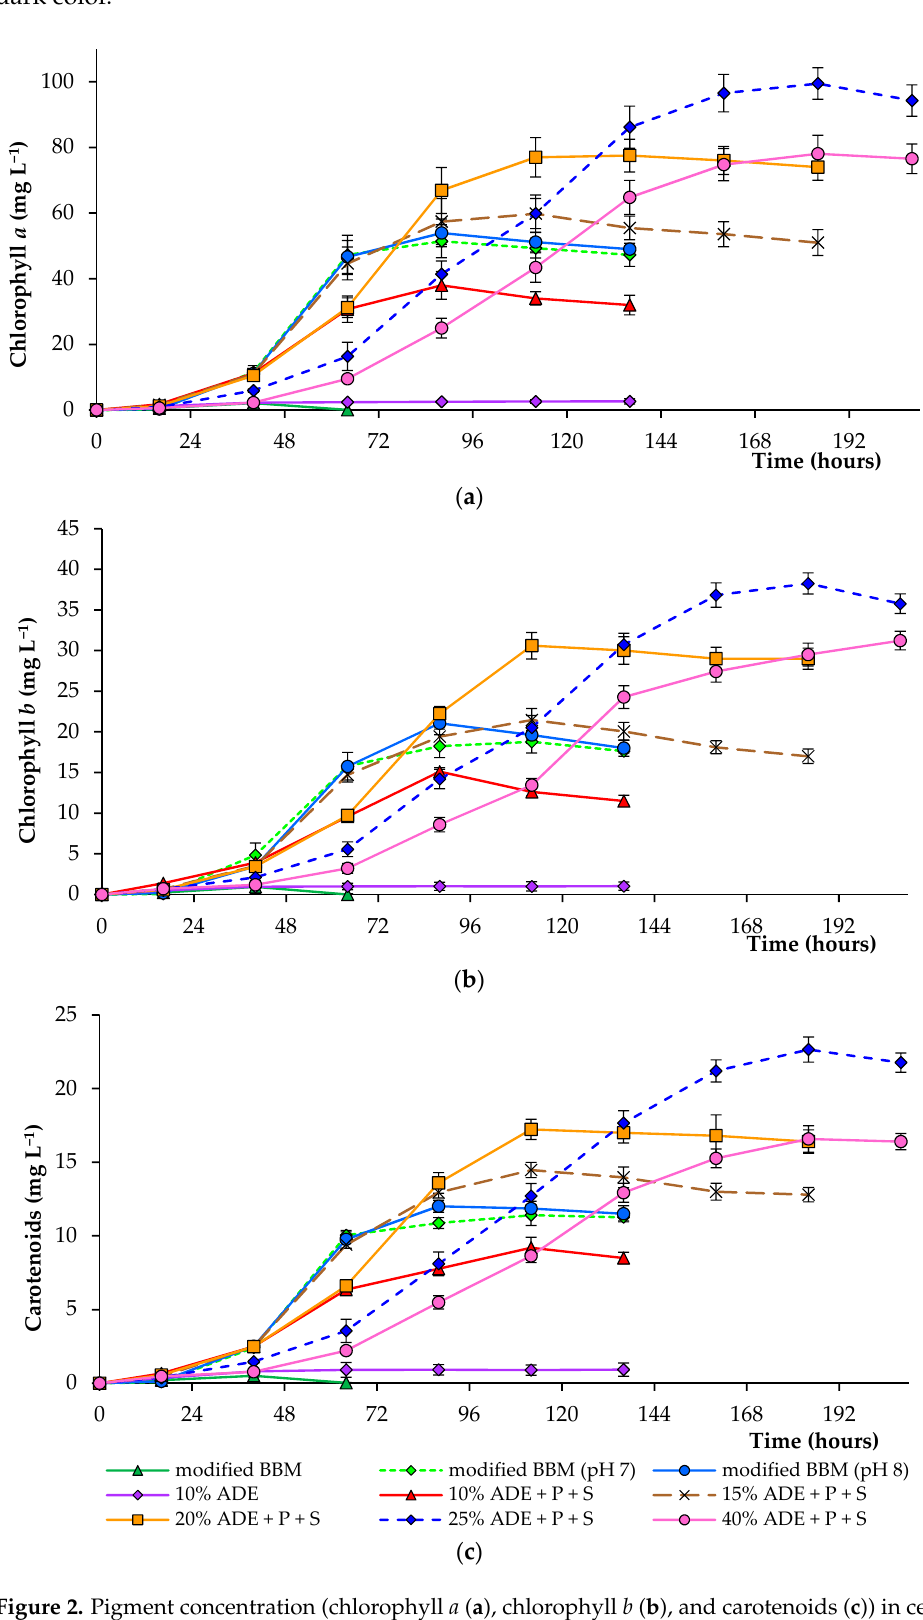
Figure 2. Pigment concentration (chlorophyll a ( a ), chlorophyll b ( b ), and carotenoids ( c )) in cells of C. sorokiniana AM-02 cultured under different